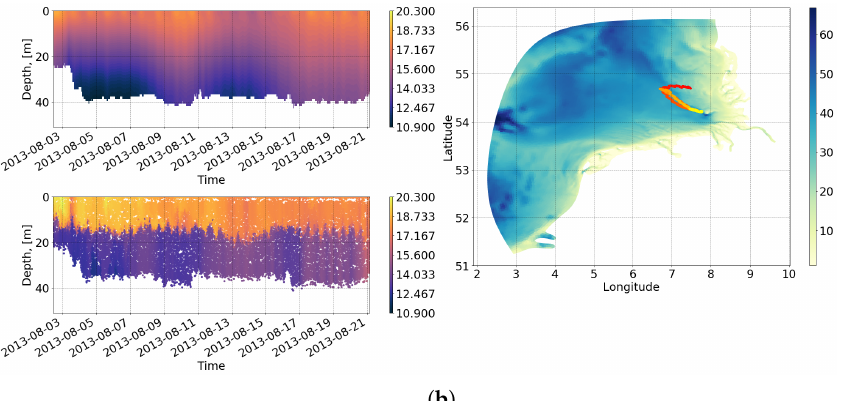
Figure 15. Comparison of model temperature with observed data from gliders: ( a ) February 2011; ( b ) August 2013. Colored circles on the bathymetry maps (at right) show glider paths; colors indicate position times from red (beginning of the survey) to yellow (end of the survey). The filled contours at upper left are model results (21 sigma levels, 2010–2014 run). The scatter data at bottom left are from gliders (COSYNA database [51]). The glider data time resolution is about 1 min, or 20 m horizontal resolution. The spatial resolution of the model is between 1 and 4